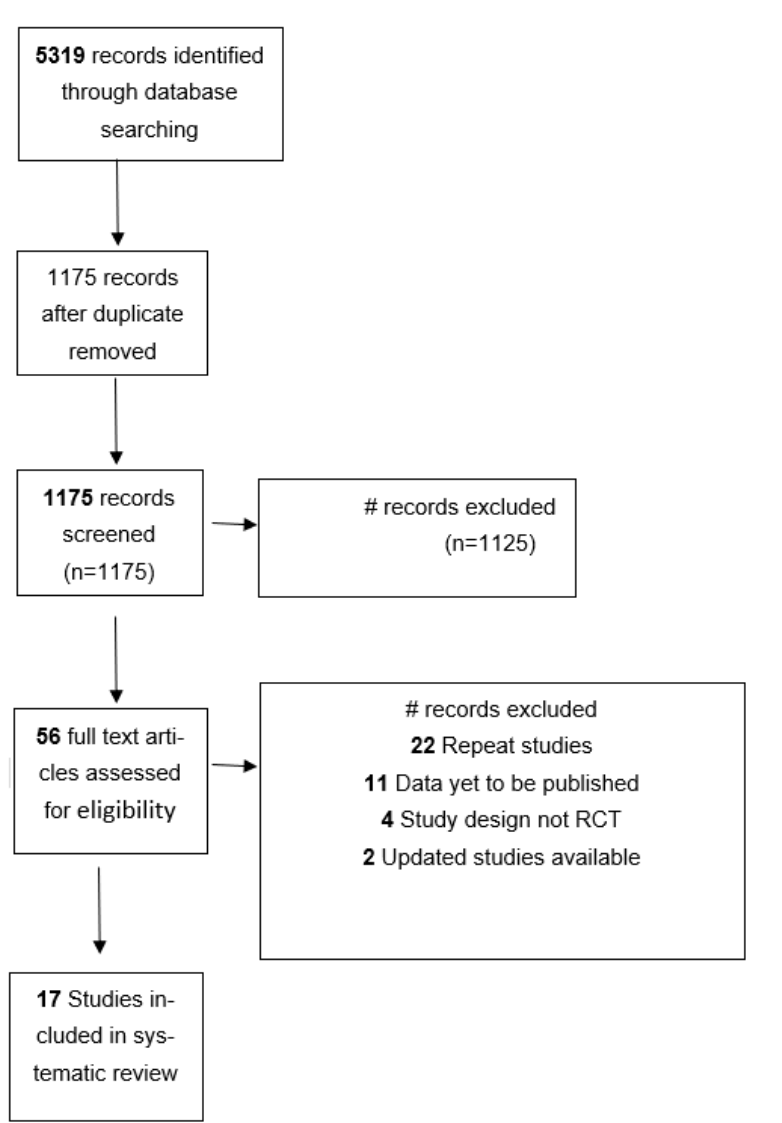
Figure 1. PRISMA diagram showing study selection flowchart.